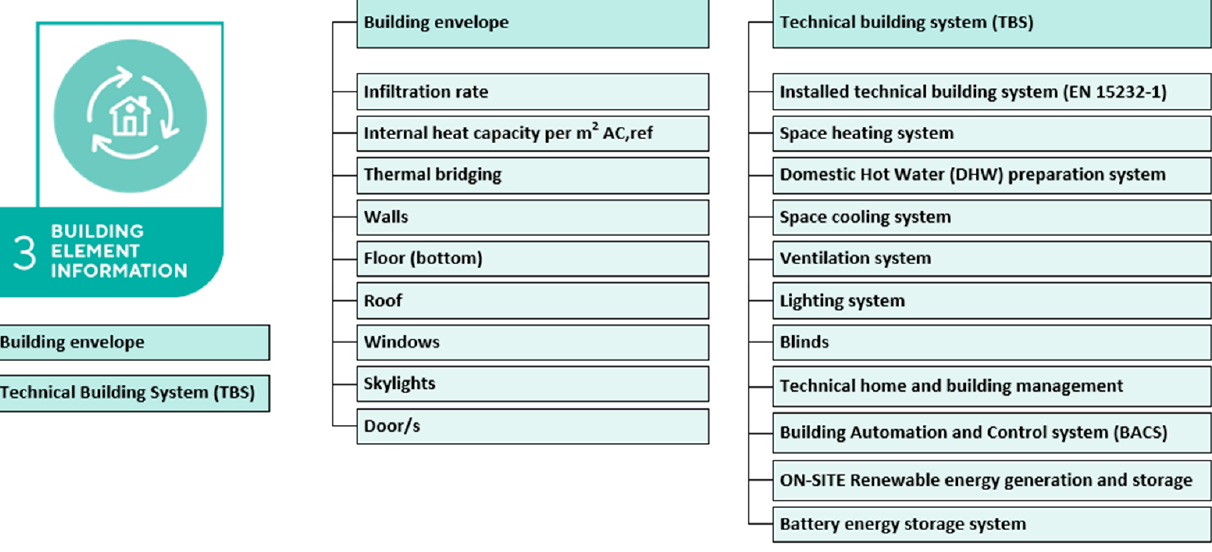
Figure 5. 3-Building Element Information: overview of main subcategories.